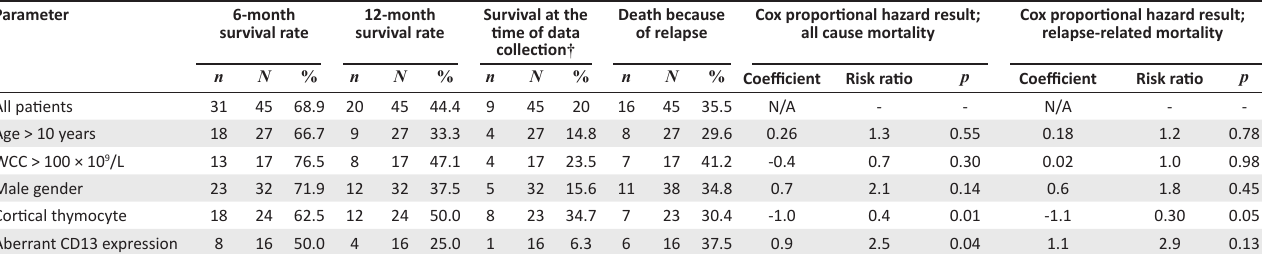
TABLE 3: Pertinent survival data. Parameter 6-month